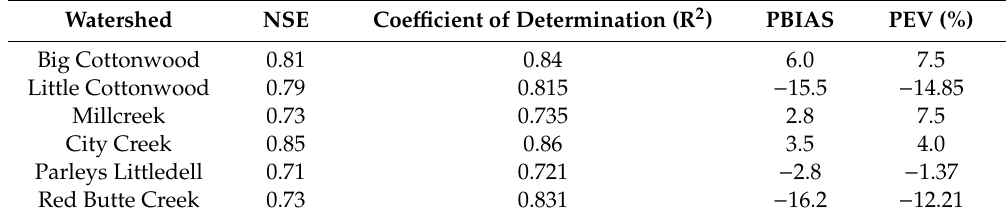
Figure 5. Calibration results of the hydrologic models developed for the studying watersheds . Table 3. Results of di ff erent statistical tests to evaluate the calibration of the models.